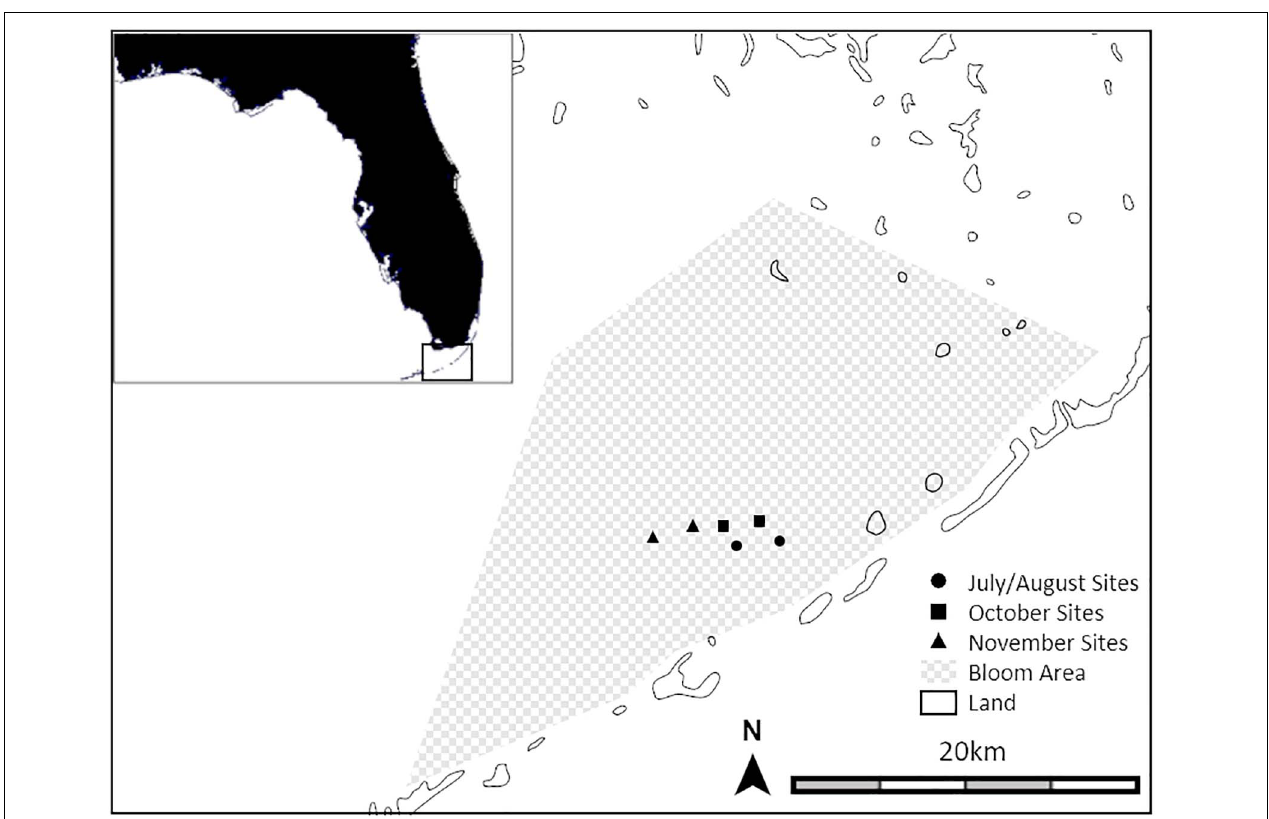
FIGURE 1 | Map showing the six experimental soundscape broadcast locations including the approximate extent of hardbottom habitat degraded by cyanobacteria blooms and sponge die-offs. (map: